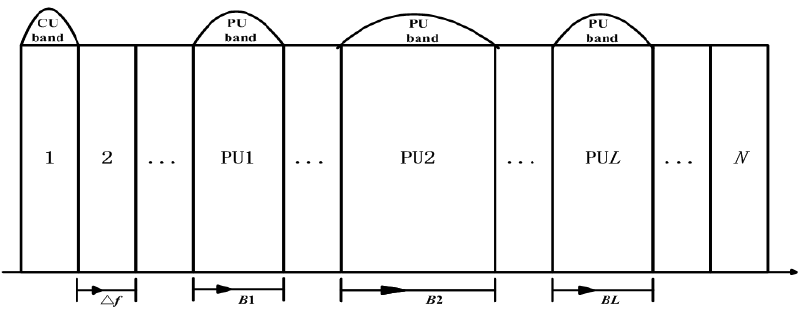
Figure 3. spectrum access model of cognitive radio